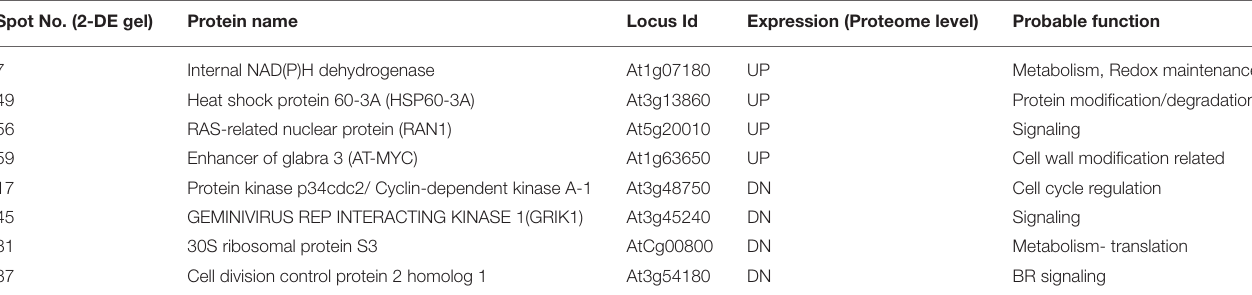
Protein kinase p34cdc2/ Cyclin-dependent kinase